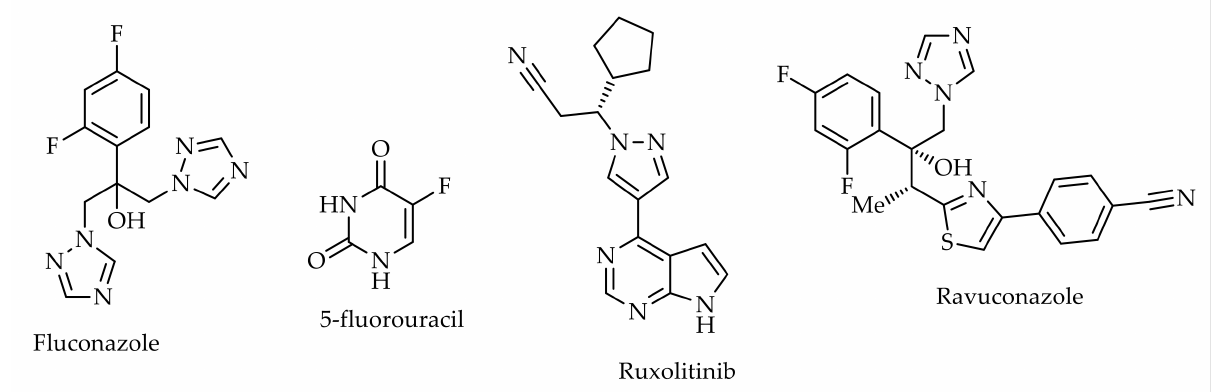
Figure 1. Representative examples of bioactive nitrogen-containing